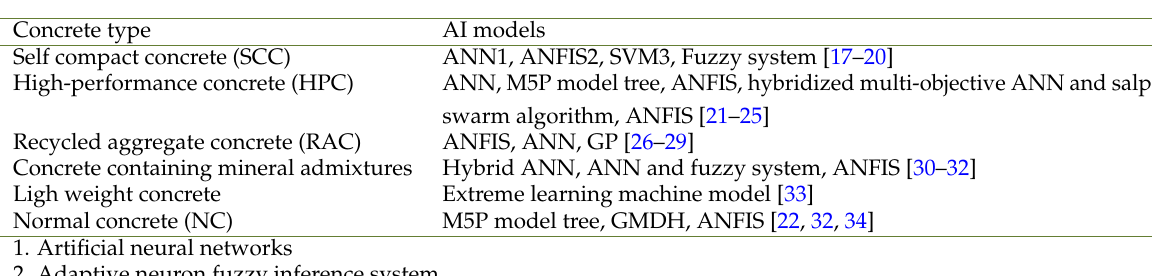
Table 1. Different methods for estimating the compressive strength of concrete types using various kinds of